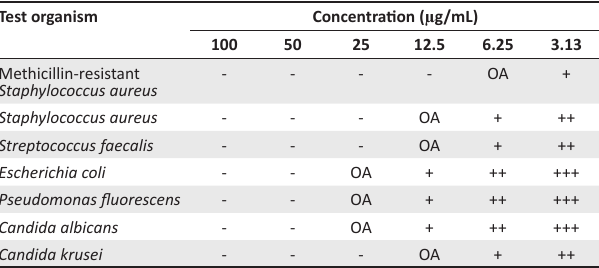
TABLE 2: Minimum inhibitory concentration of stigmasterol on the test organisms. Test organism